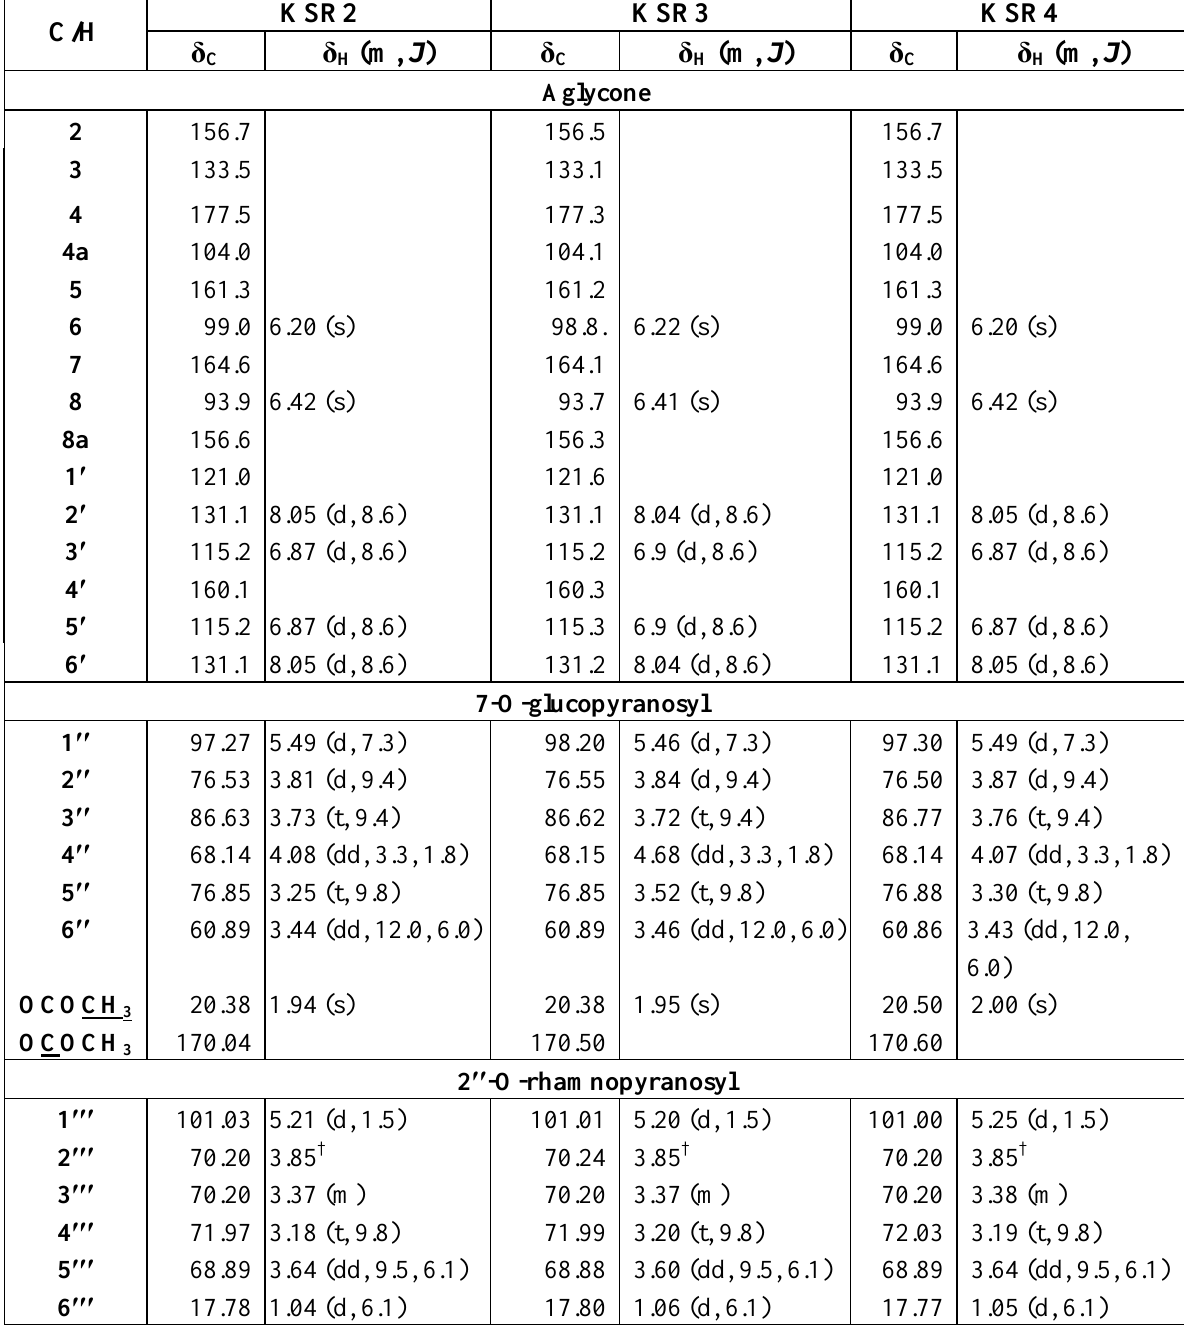
Table 2 . 13 C- (125 MHz) and 1 H-NMR (500 MHz) spectral data for the aglycone and trisaccharide moieties attached at the C-7 position in KSR2 , 3 and 4 * (D